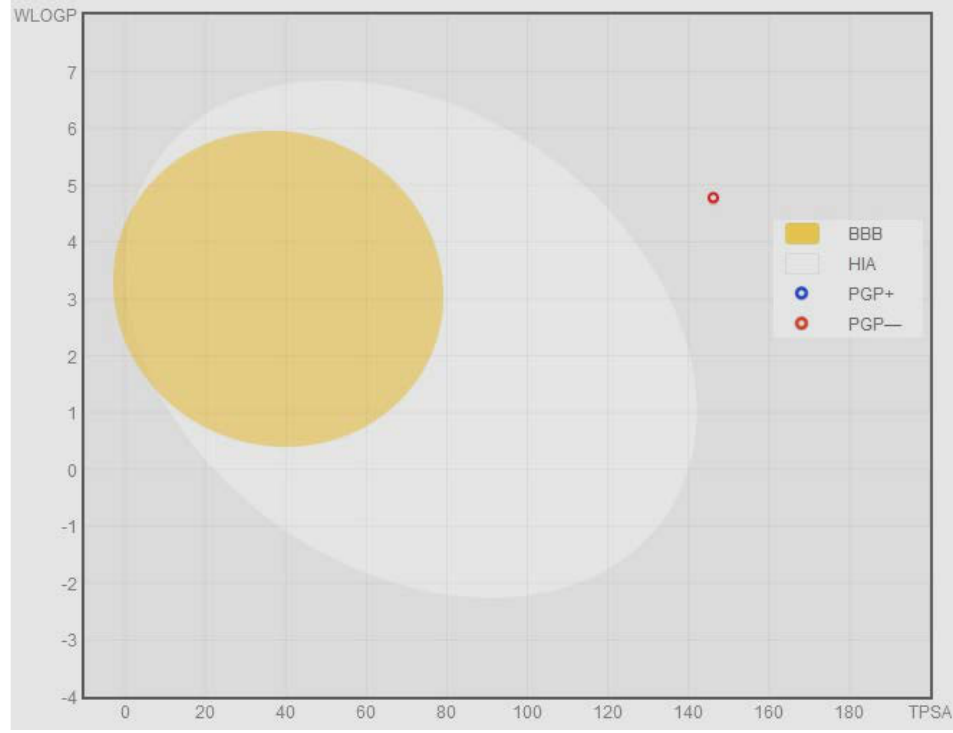
Figure 10. Human intestinal absorption (HIA) and blood-brain barrier (BBB) plot for 4h.